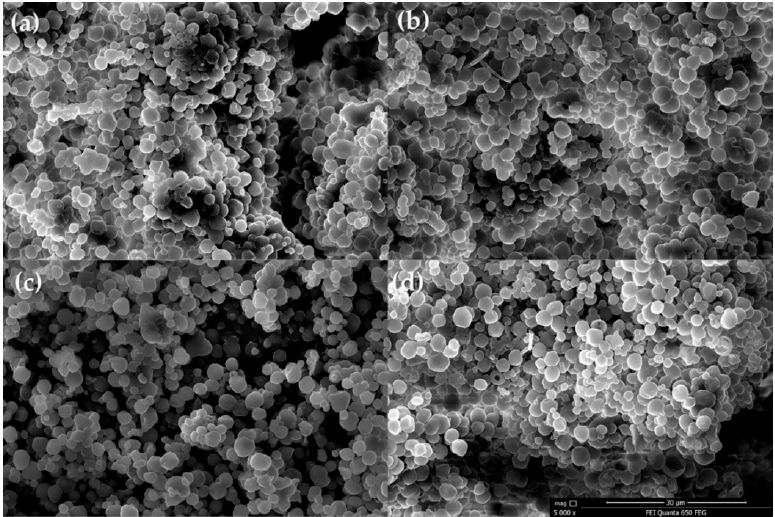
Figure 7. Scanning electron micrographs of obtained structures: particles with poly(allylamine hydrochloride) ( a ), heparin ( b ) and dextran ( c ) outer layers and pure cores ( d ).